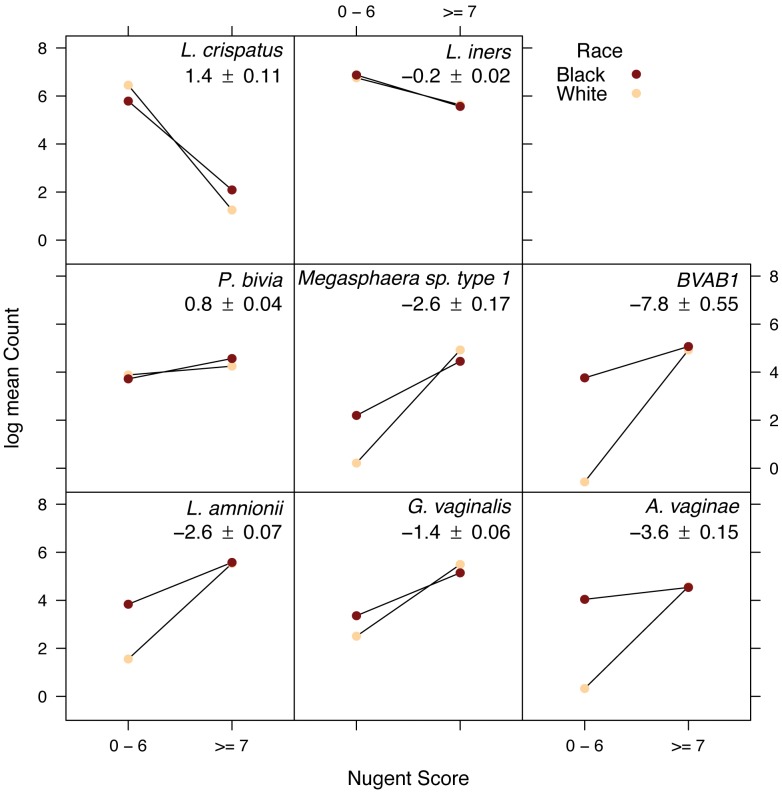
Association of race with vaginal microbiota.A general linear model (see Methods for additional detail) was used to describe interactions between race and BV status as determinants for bacterial prevalence. On the x-axis, BV was assessed by Gram stain: 0–6, BV negative; 7–10, BV positive. On the y-axis counts were sequence reads in each group; values summarized in the figure are log-transformed average counts in each group. Values below each taxonomic identifier are the estimate of the strength of the interaction +/− one standard error; large positive values indicate a more positive (less negative) slope amongst Black women than White women. Eight of 28 bacterial taxa showing greatest interaction with race are displayed.